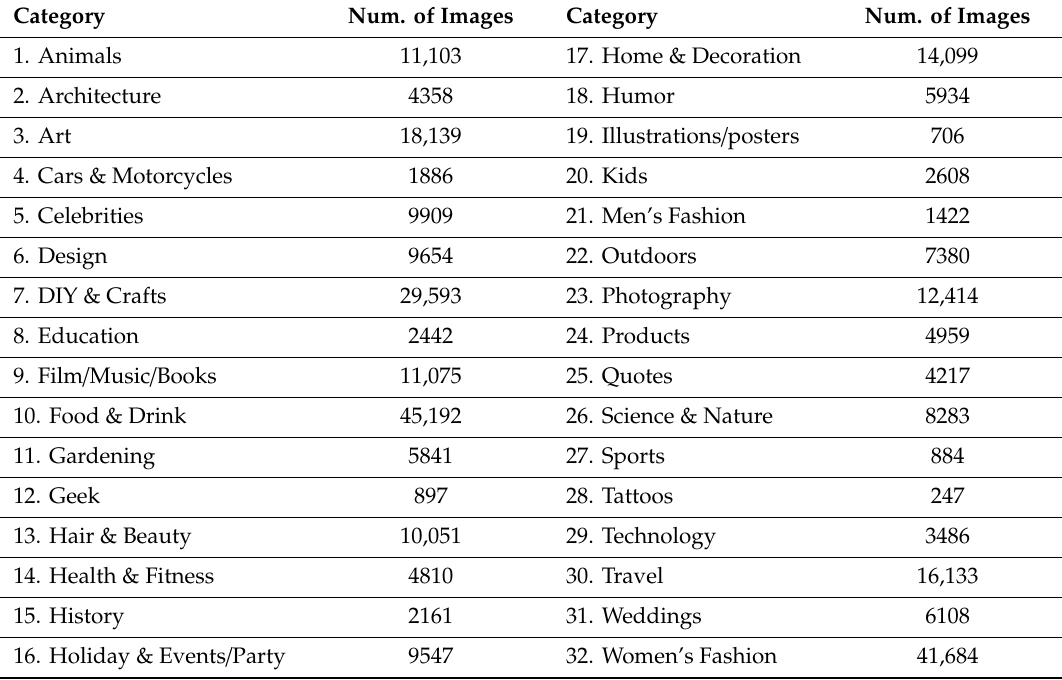
Table 1. Categories and number of images in our DB1 database corresponding to categories in Pinterest. Category Num. of Images Category Num. of